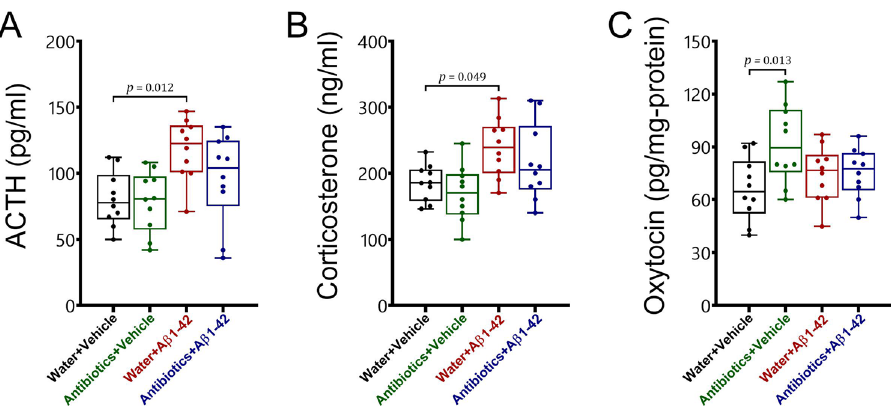
Figure 7. The effects of antibiotic treatment alone or in combination with Aβ1–42 treatment on HPA axis function ( A ACTH; B corticosterone) and brain oxytocin ( C ) in male C57BL6 mice. Data are expressed as mean ± SEM (n = 10). Antibiotic treatment significantly increased brain oxytocin [ p = 0.013] but did not alter [ p > 0.05] ACTH and corticosterone levels in the serum of mice as compared to the water + vehicle group. In addition, Aβ 1–42 administration significantly increased ACTH [ p = 0.012] and corticosterone levels [ p = 0.049] but not brain oxytocin [ p > 0.05] in water-treated mice as compared to the water + vehicle group. Furthermore, no significant differences [ p > 0.05] in ACTH, corticosterone, and oxytocin levels were observed between antibiotics + Aβ 1–42 mice and antibiotics + vehicle or water + vehicle